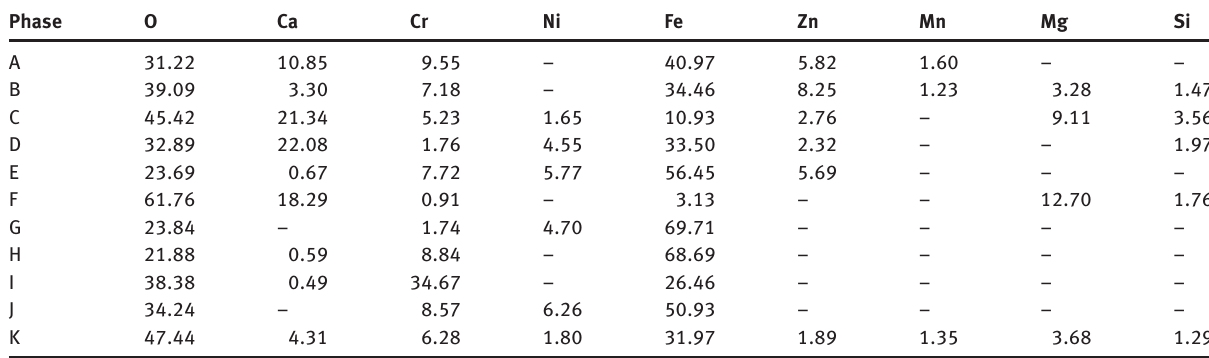
Table 4: Chemical compositions of each particle shown in Fig. 2 (EDX analysis, mass%) Phase